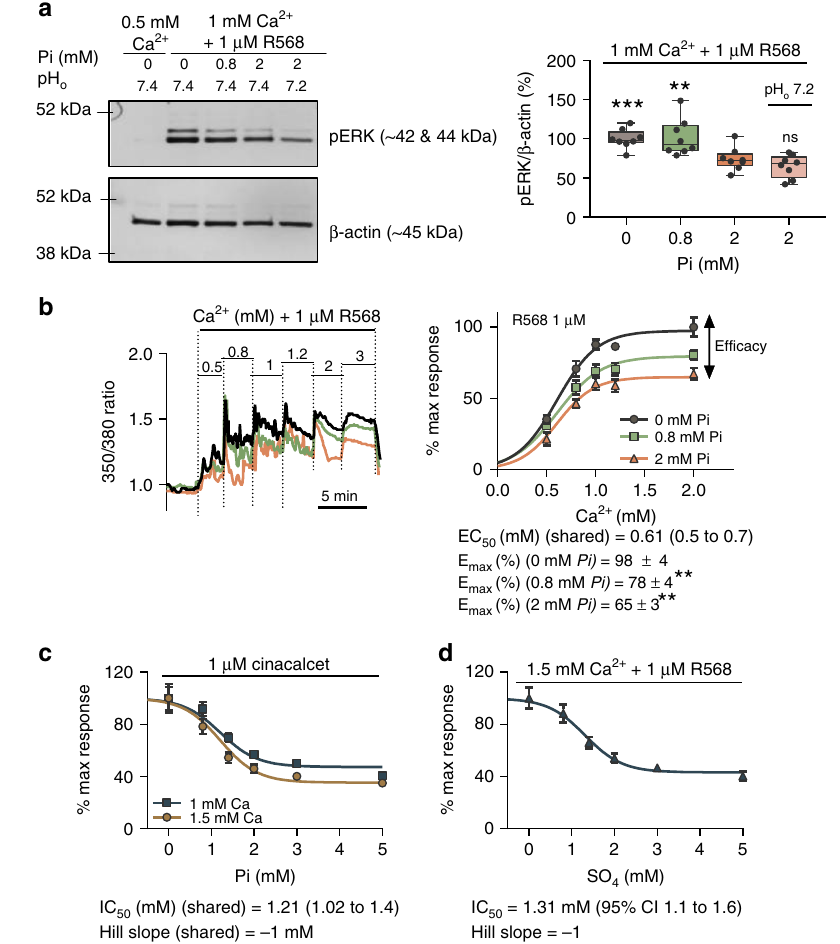
Fig. 2 Pi inhibits the CaSR in a noncompetitive manner. a Representative immunoblot showing Pi-mediated inhibition of CaSR-induced pERK after 10 min of treatment with Pi and acidosis (pH 7.2). Changes in pERK were determined by densitometry, corrected for β -actin abundance and normalized to Pi-free CaSR-stimulated control ( n = 8 dishes from four experiments; 0.5 mM Ca 2 + shown as a negative control). b Representative traces showing Ca 2 þ i mobilization from single cells exposed to buffers containing increasing levels of Ca 2 þ o (left), and Ca 2 + concentration-effect curves (right) in the presence of 0 ( n = 7), 0.8 ( n = 9), and 2 ( n = 10) mM Pi from three independent experiments. E max expressed as %mean ± SEM. c Pi concentration-effect curves for Ca 2 þ i -mobilization upon stimulation with cinacalcet and 1 or 1.5 mM Ca 2 þ o ( n = 7, two independent experiments). d SO 4 concentration-effect curves for Ca 2 þ i -mobilization upon stimulation with R568 and 1.5 mM Ca 2 þ o ( n = 8, two independent experiments). b – d Area under the curve was calculated for each treatment and normalized to maximal response. Data were fi tted to a four-parameter Hill equation (Eq. (1)) for sigmoidal dose response variable slope, and fi tted best when EC fi dence interval), were shared among data sets, P < 0.01 extra sum-of-square F -test. 50 ( b )/IC 50 ( c , d ), expressed as mean (95% con Data expressed as %mean ± SEM. Data were analyzed by using RM-ANOVA with Dunnett ’ s multiple comparisons, ns not signi fi cant; * P < 0.05, ** P < 0.01, and *** P < 0.001. Source data are provided as a Source Data fi